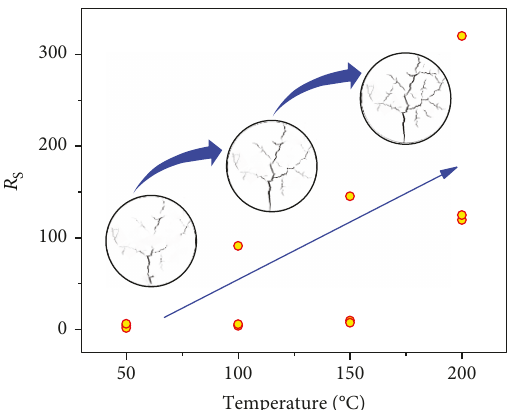
Figure 10: E ff ect of processing temperature on R